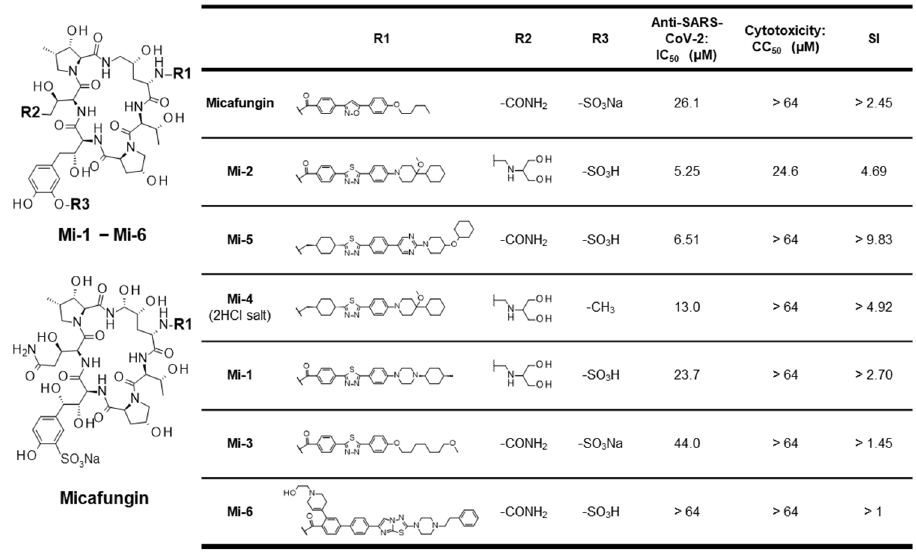
Figure 2. Structure–activity relationship of micafungin derivatives with anti-SARS-CoV-2 activity, cytotoxicity, and selectivity index (SI = CC 50 /IC 50 ) observed in VeroE6/TMPRSS2 cells. The base structure ( left ) and the moieties at R1, R2, and R3 ( right ) are shown.